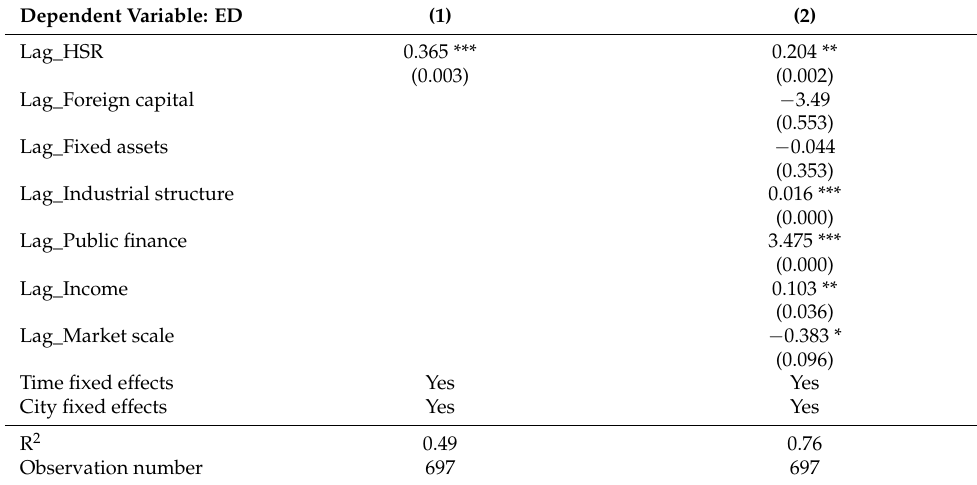
Table 6. Robustness test—lag